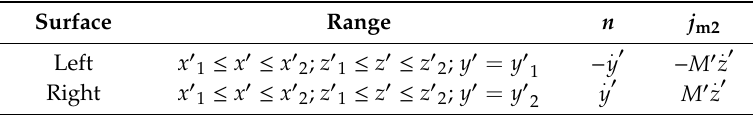
Table 2. Equivalent surface current of MG2 on the magnet’s